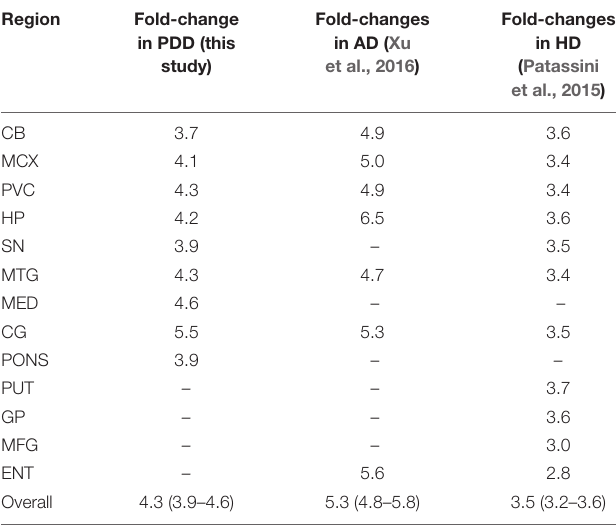
TABLE 2 | Urea fold-changes in PDD, AD, and